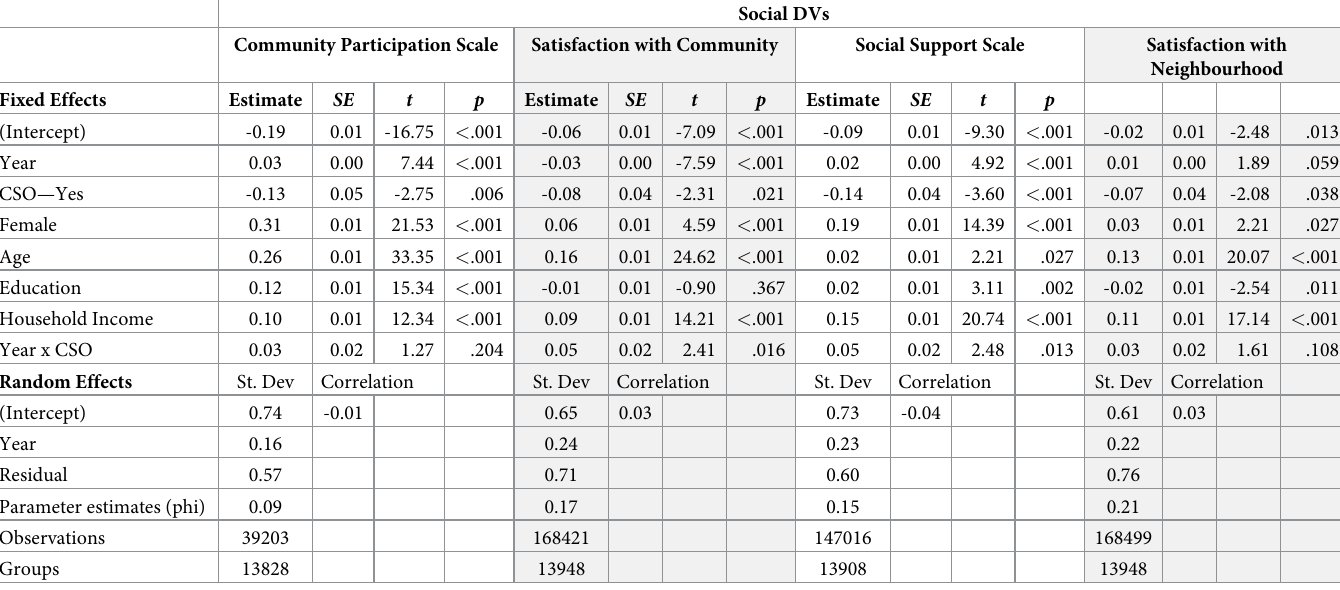
Table 3. Generalised linear mixed-effects model results for social wellbeing